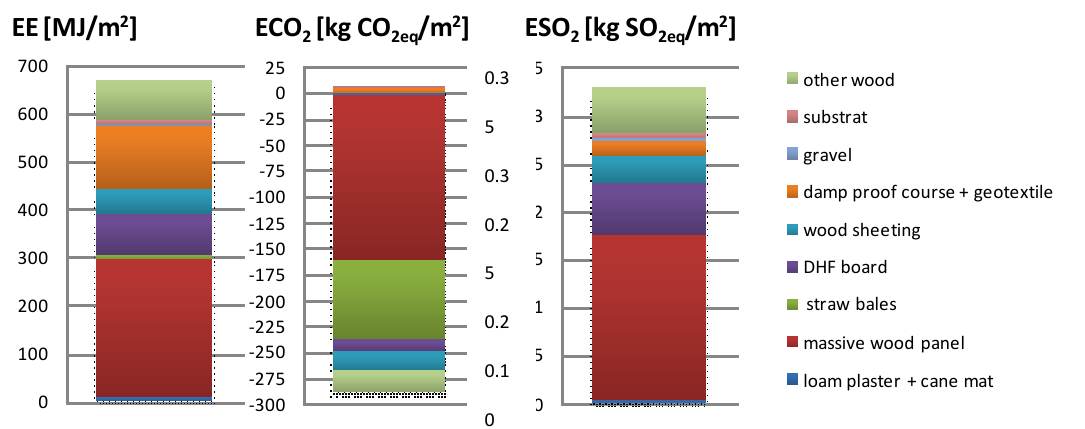
Figure 15. Roof structure: Impact of materials on environmental